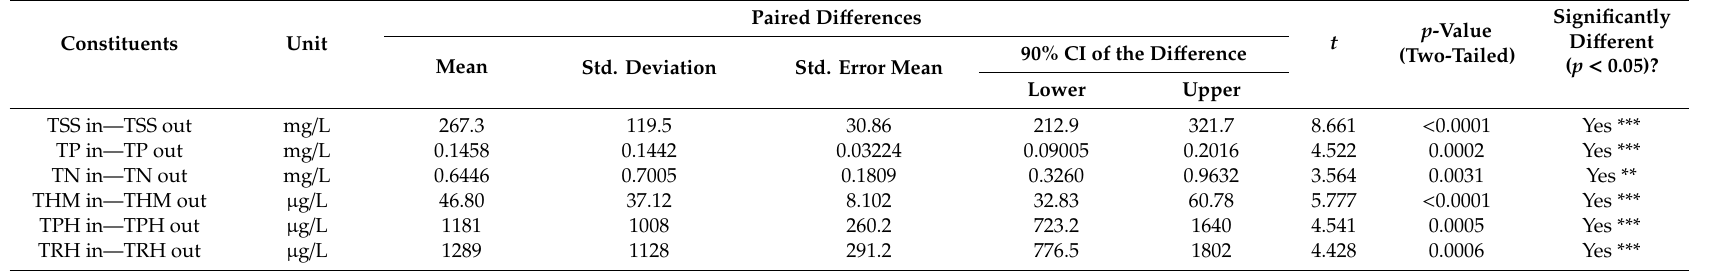
Table 5. Parametric test results—Paired Samples t